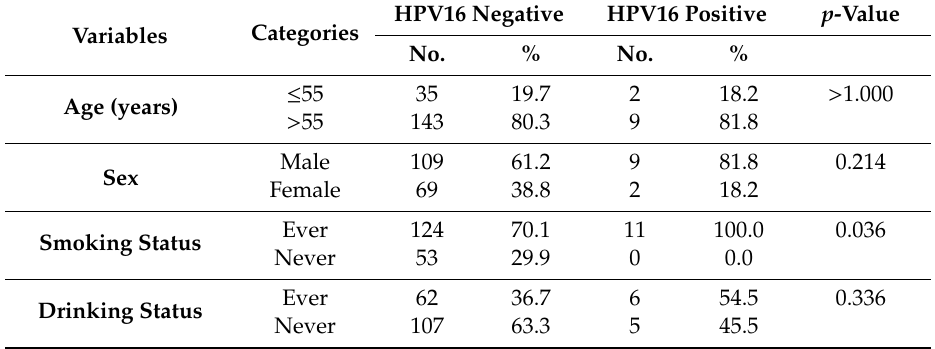
Table 2. Di ff erences between HPV16 negative and HPV16 positive patients with oral